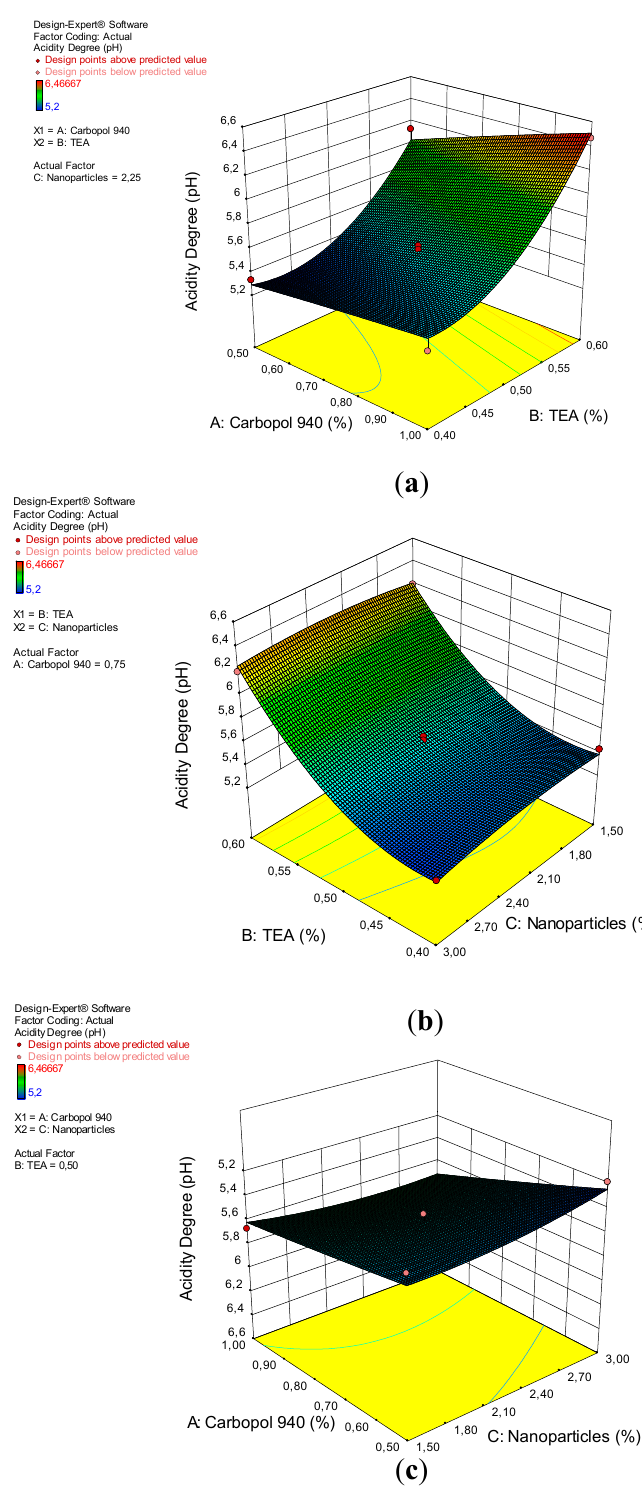
Figure 3. A 3D plot of the relationship between ( a ) carbopol 940 and TEA and the acidity degree, ( b ) TEA and nanoparticles and the acidity degree, and ( c ) carbopol 940 and nanoparticles and the acidity degree.